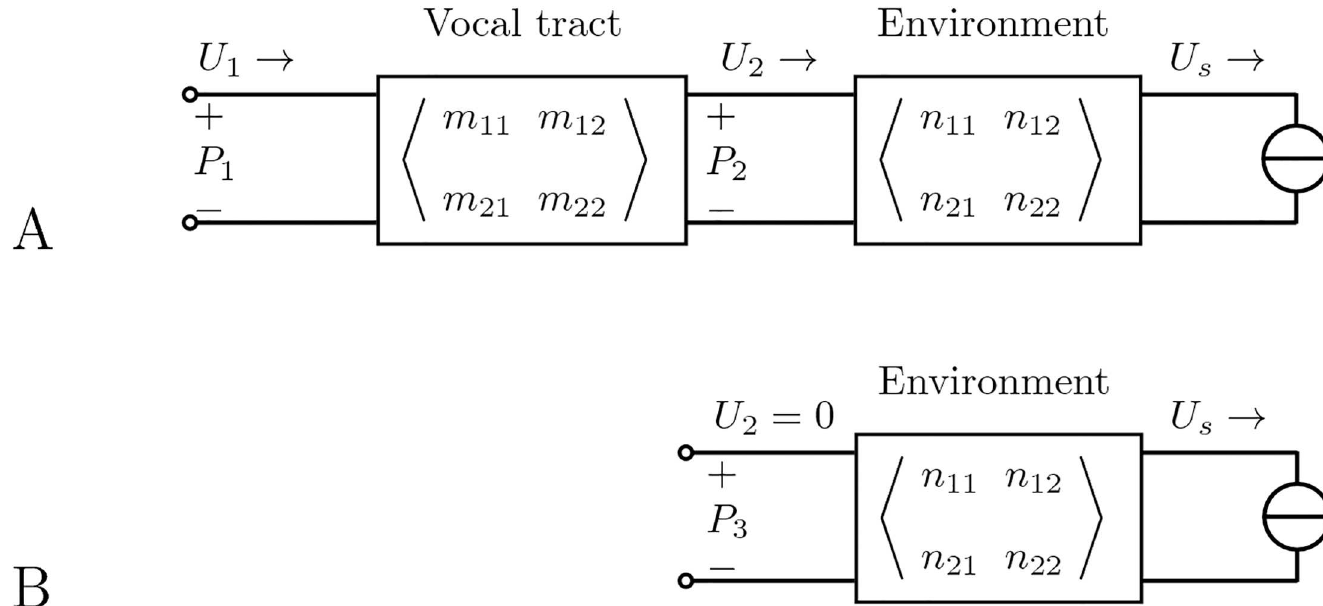
Fig 2. Theoretical model of the measurement setup. Equivalent acoustic circuits for the measurement situations in Fig 1A and 1B, respectively.